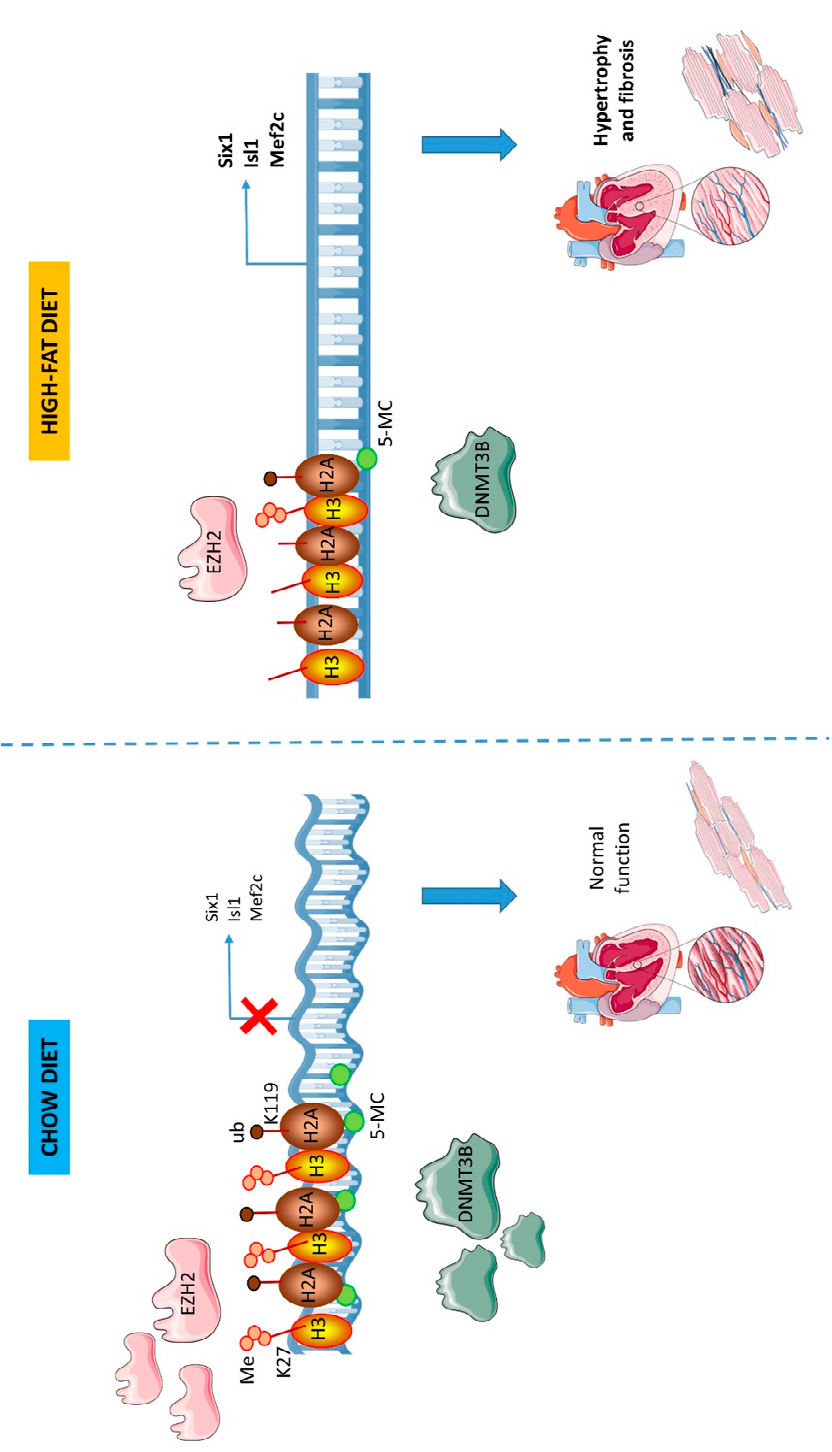
Figure 4. E ff ects of maternal exposure to high-fat diet on cardiac epigenetic repressive marks. Maternal exposure to high-fat diet induces long-term decrease in EZH2 levels. This leads to H3K27me2 / 3 down-regulation. At the same time, DNMT3B levels are decreased leading to down-regulated CpG methylation levels. These alterations mediate chromatin decompaction and subsequent activation of pro-hypertrophic and pro-fibrotic genes ( Six1, Isl1 and Mef2c